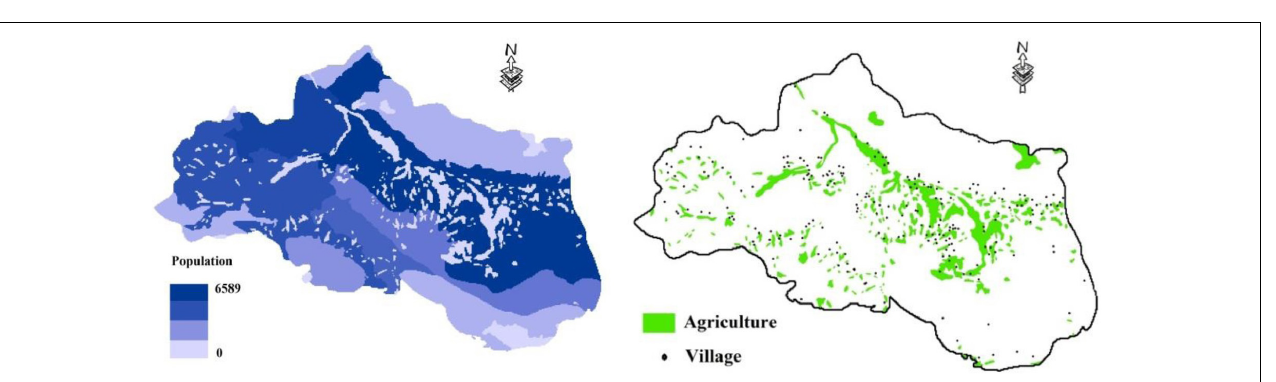
R xj is the Budyko dryness index on pixel x with land use and cover j